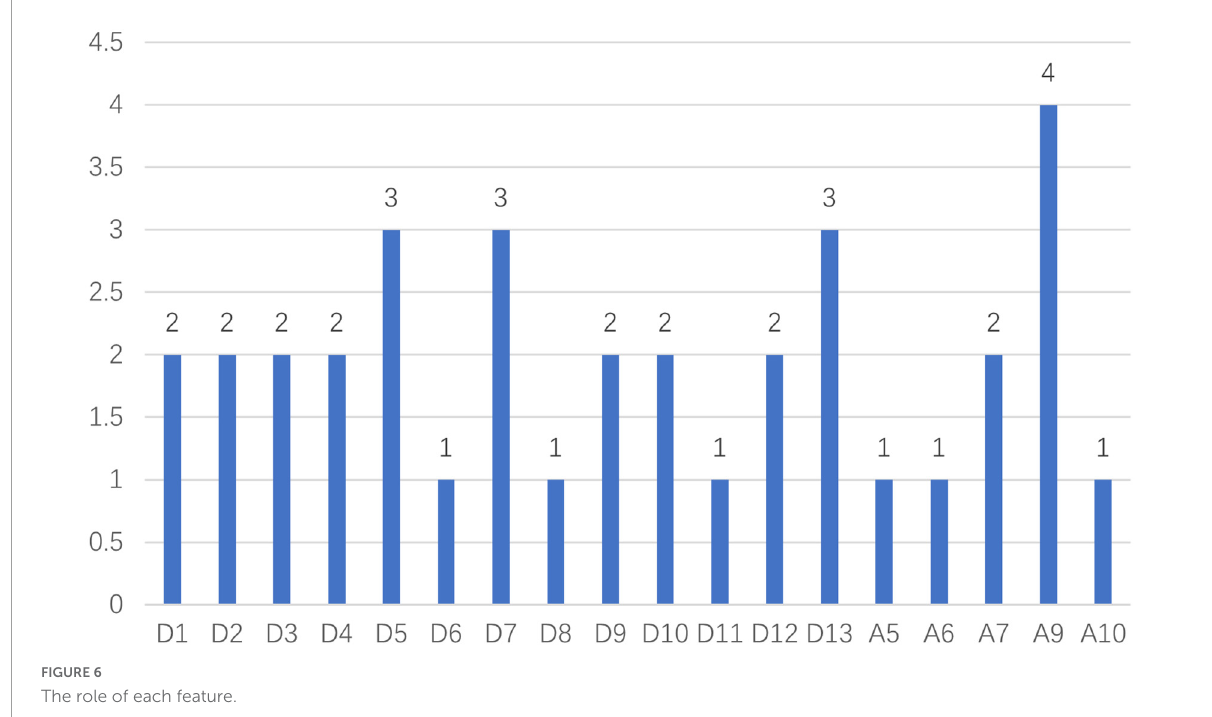
FIGURE6 The role of each